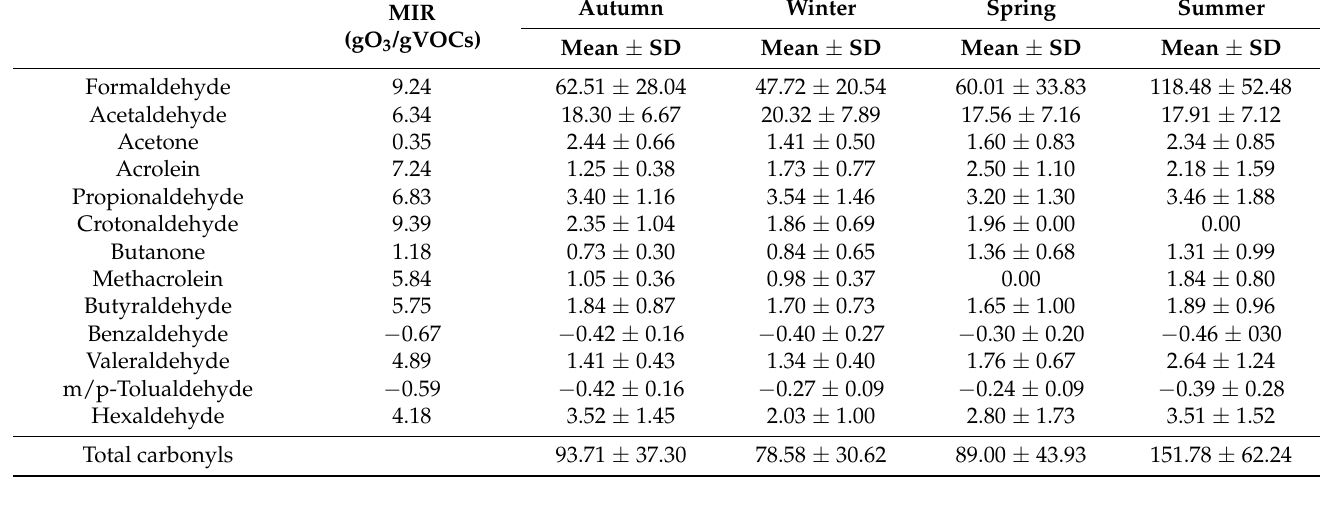
Table A3. Average ozone formation potentials of carbonyls in different seasons (μg/m³).